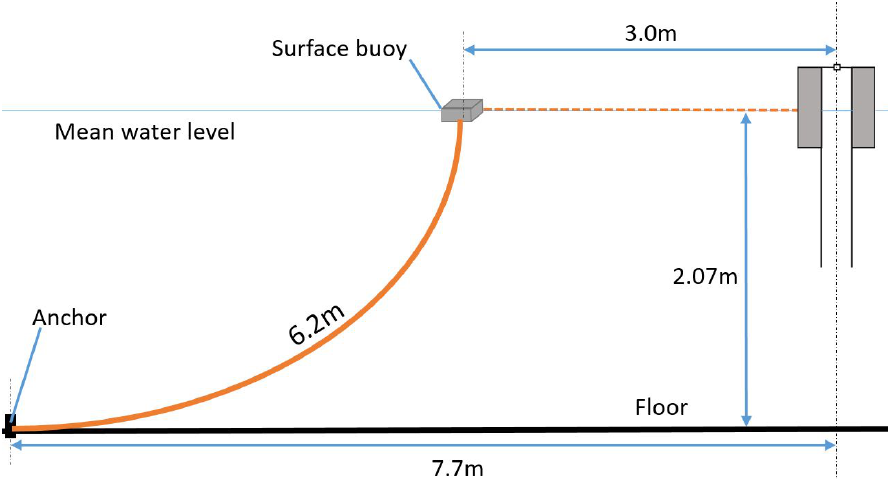
Figure 9. Schematic of a mooring line. The device was moored by 3 mooring lines with 120 degrees between any two mooring